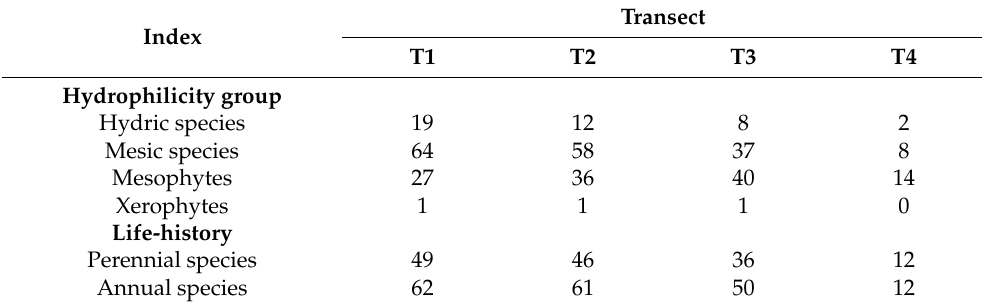
Table 1. Plant hydrophilicity and life history characteristics of the four transects in the MLHR, China.